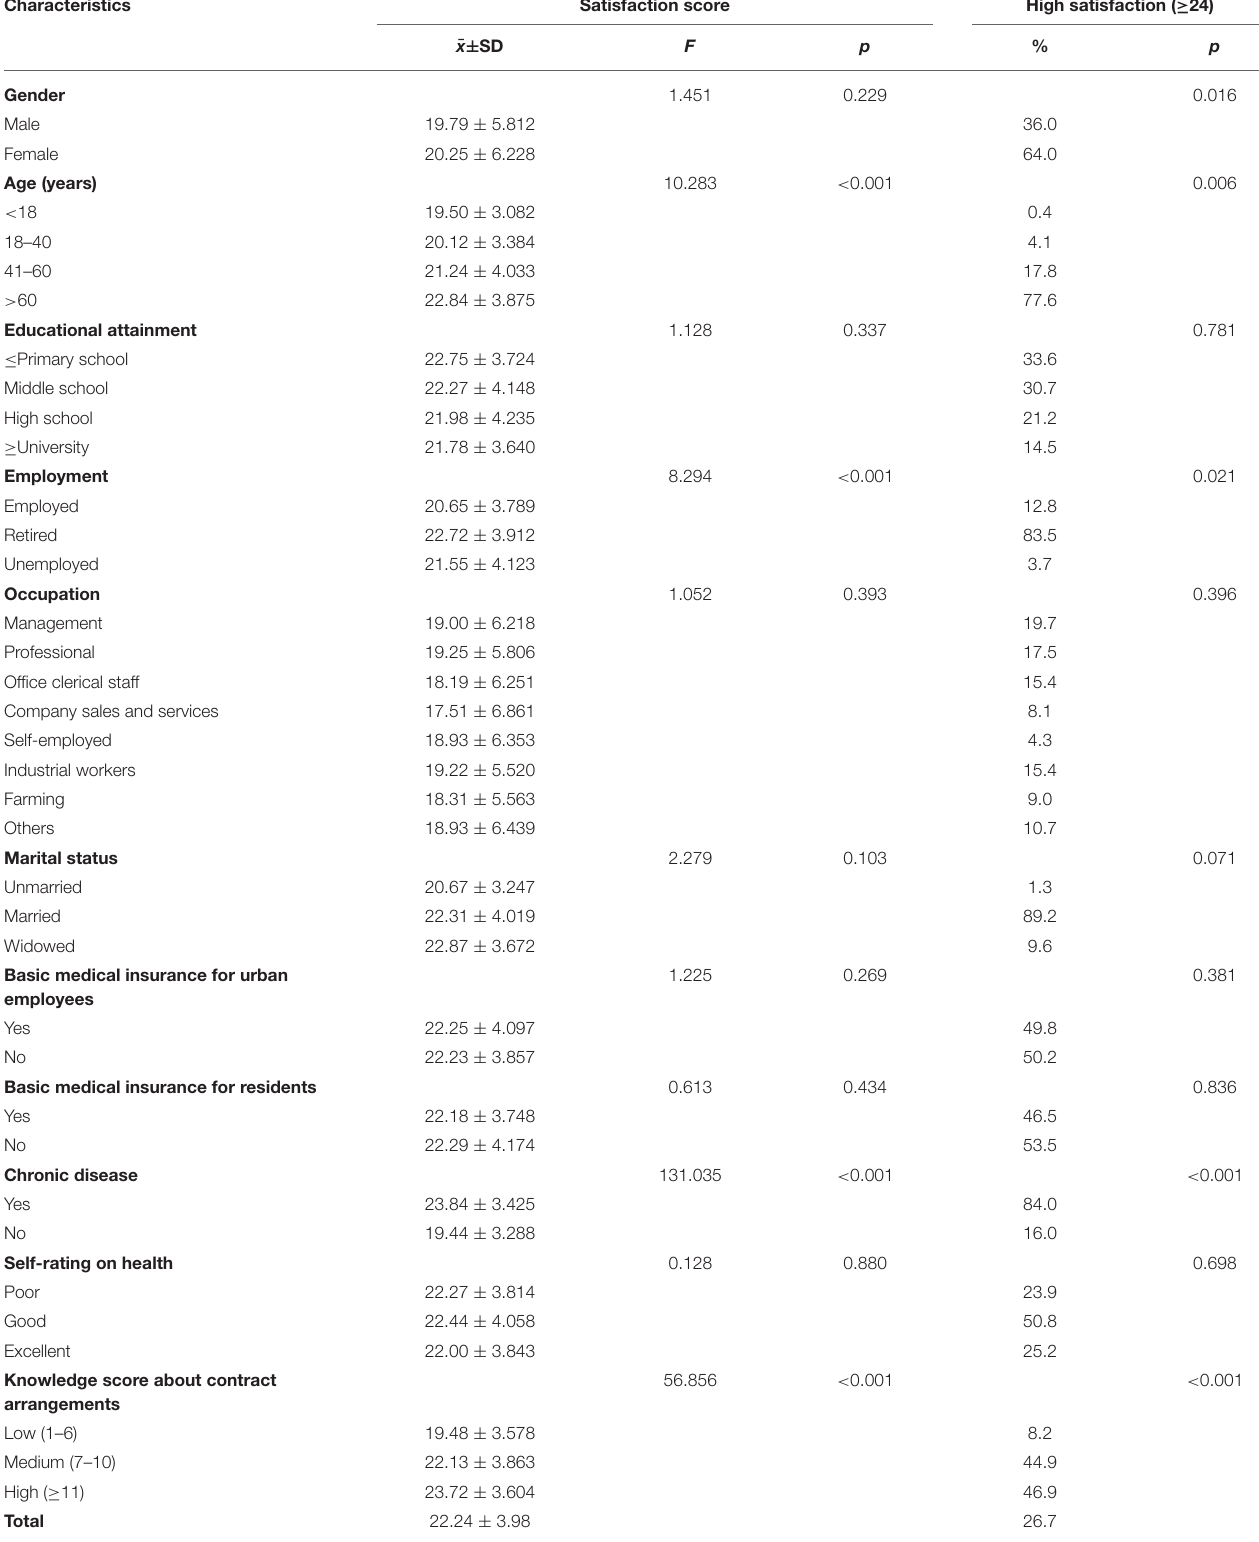
TABLE 4 | Satisfaction with contract arrangements of respondents with different characteristics.